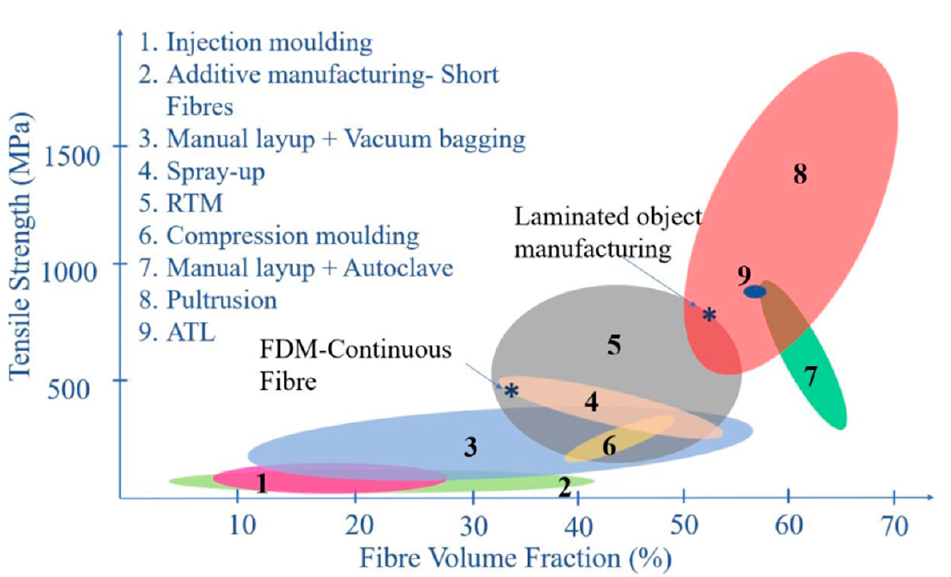
Figure 6. Tensile strength of various short fiber-reinforced polymer composites with different fiber volume fractions. (RTM: Resin Transfer Molding; ATL: Automated tape laying; FDM: Fused deposition modelling) [124].